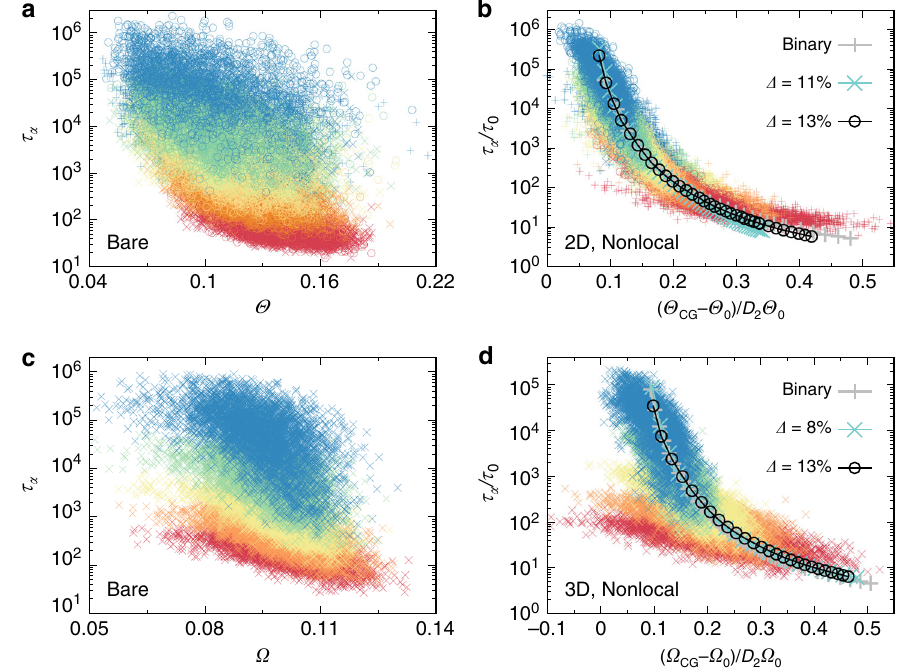
Fig. 4 Microscopic relation between structural order and dynamics. a Microscopic τ α as a function of bare structural order Θ for 2D BM and PM ( Δ ¼ 11 % and 13 % ) at different temperatures. b Corresponding to a , microscopic τ α as a function of coarse grained structural order relative to that at T 0 , Θ of the scatter plots, the relations between macroscopic τ α and global structural order are shown together. c , d The same analysis as in a and b for 3D systems. For the ease of visualisation, here we show scatter plots only for 3D PM ( Δ ¼ 8 % ) and put those for BM and PM ( Δ ¼ 13 % ) in Supplementary Fig. 16. See Table 1 for the parameters used in the plots. The scatter plots are shown for T ¼ 2 : 4 ; 2 : 0 ; 1 : 7 ; 1 : 5 ; 1 : 35 ´ 10 (cid:2) 3 for 2D BM, T ¼ 3 : 0 ; 2 : 6 ; 2 : 3 ; 2 : 0 ; 1 : 9 ´ 10 (cid:2) 3 for 2D PM ( Δ ¼ 11 % ), and T ¼ 2 : 8 ; 2 : 3 ; 2 : 0 ; 1 : 8 ; 1 : 7 ; 1 : 51 ´ 10 (cid:2) 3 for 2D PM ( Δ ¼ 13 % ), and T ¼ 1 : 25 ; 1 : 1 ; 1 : 0 ; 0 : 9 ; 0 : 8 ´ 10 (cid:2) 3 for 3D PM ( Δ ¼ 8 % ). See Supplementary Fig. 15 for the lengths used for coarse graining. In all cases, the data colour changes from red to blue with a decrease in T